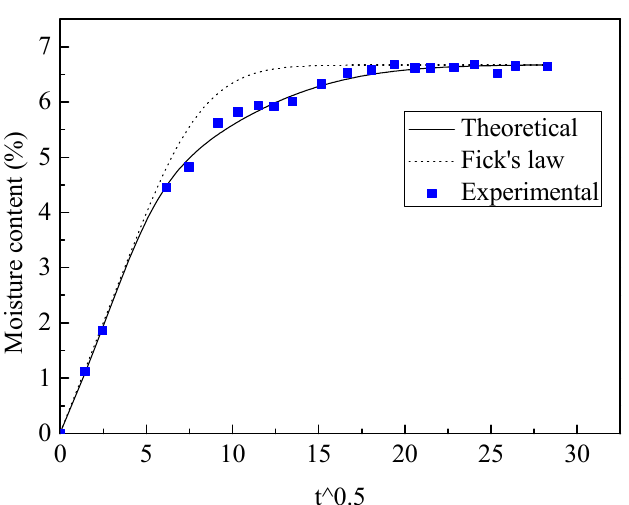
Figure 12. The experimental and theoretical moisture diffusion results for composite a.